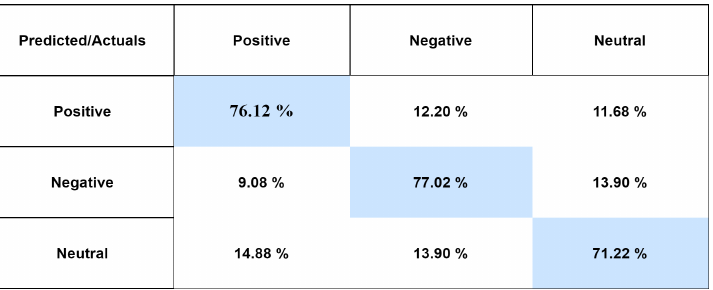
Figure 6. Confusion matrix of CNN-LSTM Roman Urdu sentiment analysis with RUSA-19 corpus.